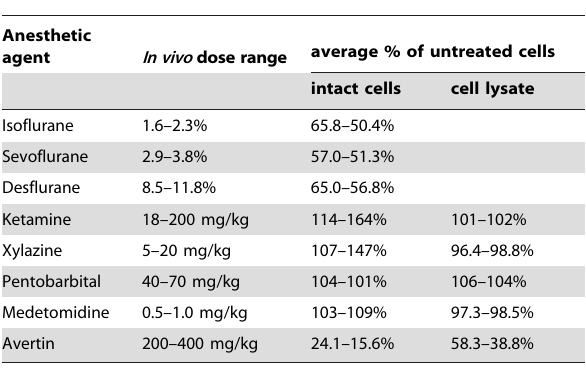
Table 3. In vitro BLI at physiological anesthetic range.